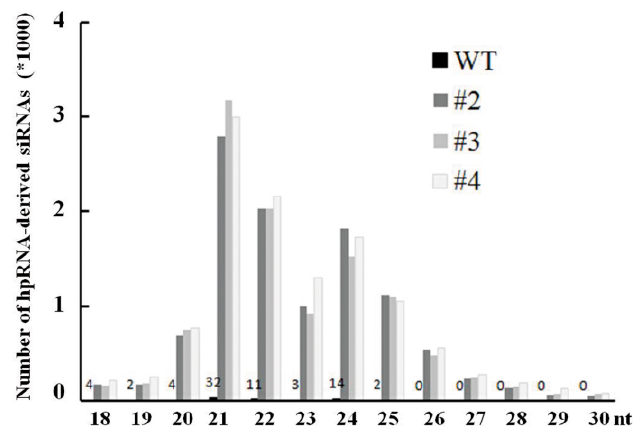
Figure 5. Size distribution of the hpRNA-derived siRNAs. WT, wild-type Kitaake; #2, #3 and #4, three independent transgenic rice lines resistant to RBSDV.